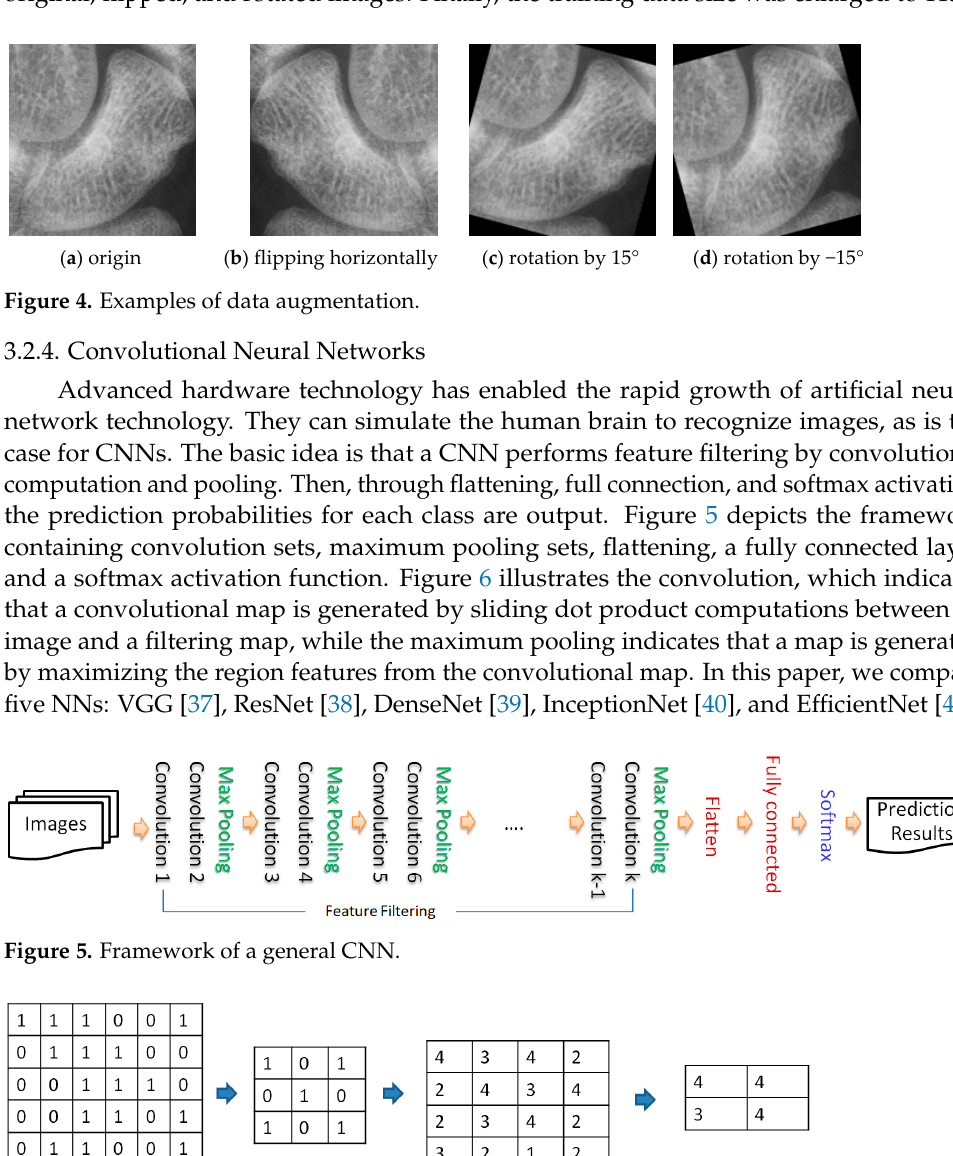
Figure 3. Examples of segmentation results using YOLO-v4.